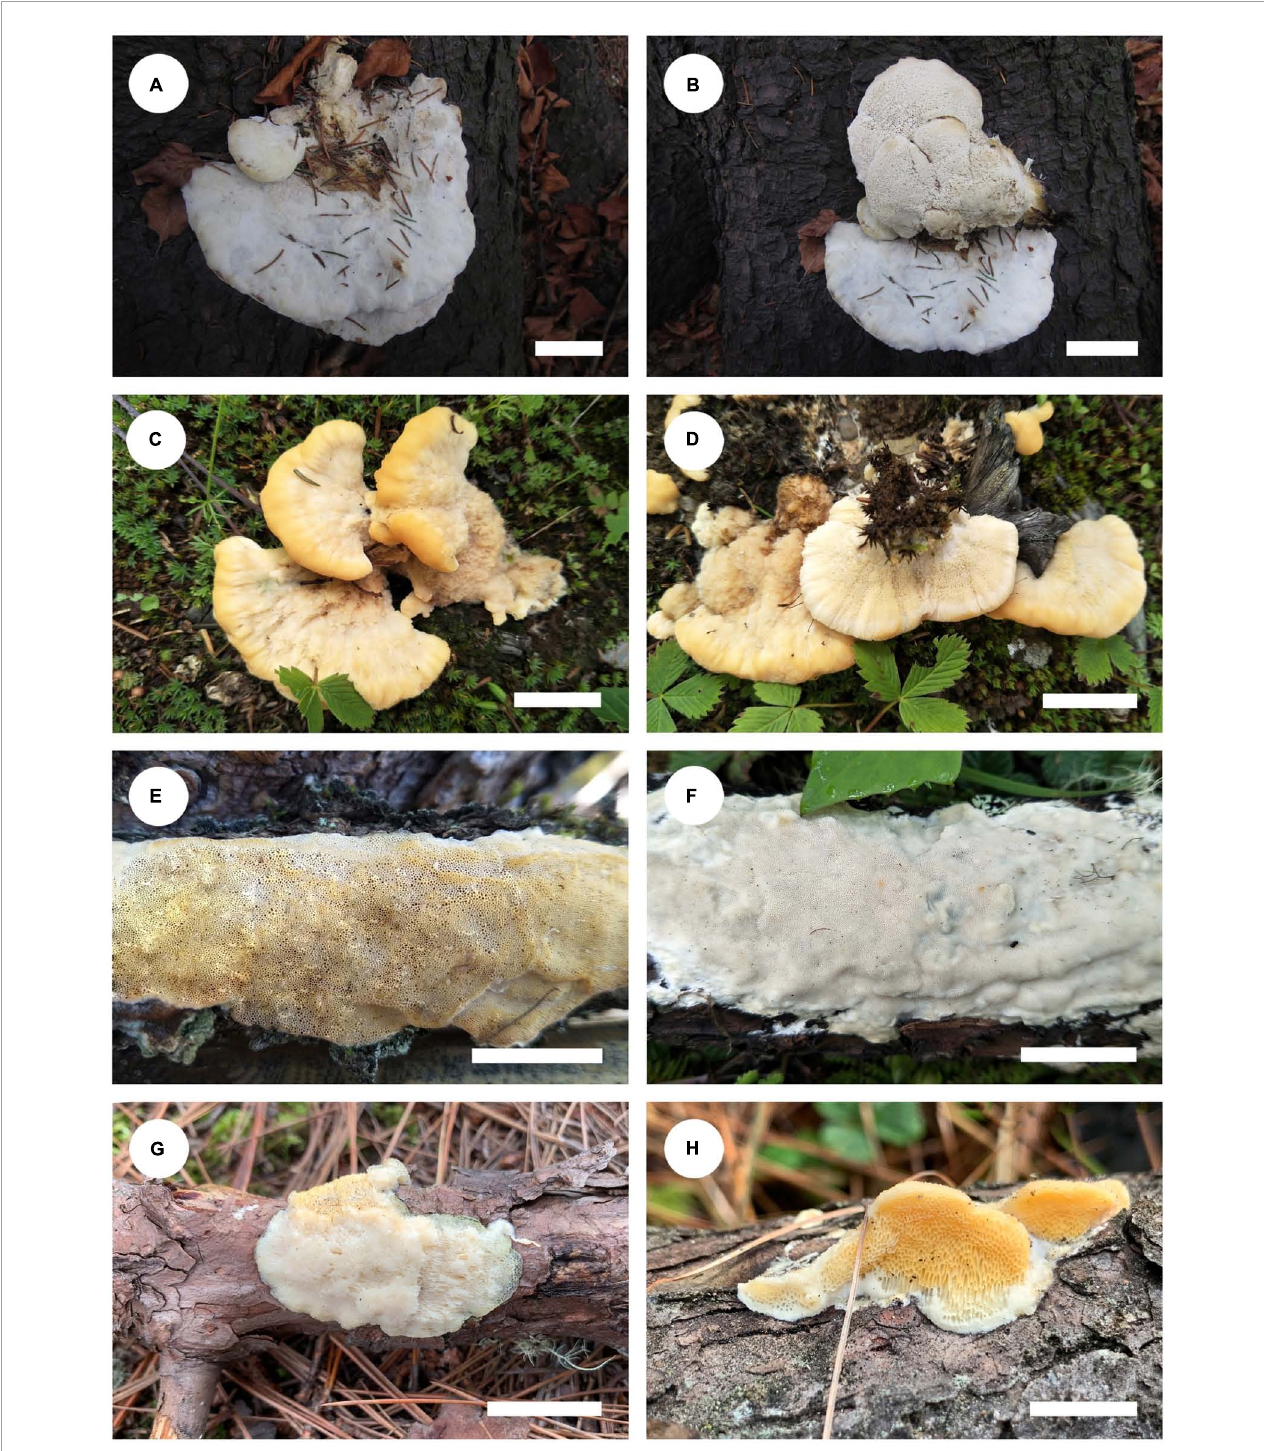
FIGURE4 Basidiomata of Climacocystis and Diplomitoporus species: C. borealis ( A,B : Dai 13028); C. montana ( C,D : Cui 17502); D. crustulinus ( E : Cui 17394; F : Cui 17475); D. flavescens ( G : Dai 22798; H : Dai 23640). Scale bars: A = 2 cm; B , C , D = 3 cm; E , F , G , H = 1.5 cm.